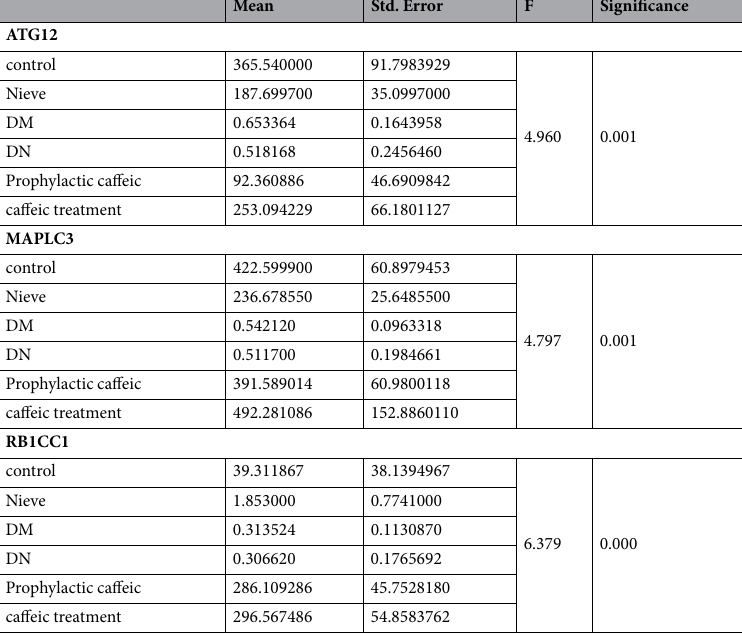
mouse hepatocytes 15 . Remarkably, caffeic acid phenethyl ester, a phytochemical extraxt of propolis was found to have antidiabetic effect and improve renal function tests in a rat model with renal tubular damage and oxidative